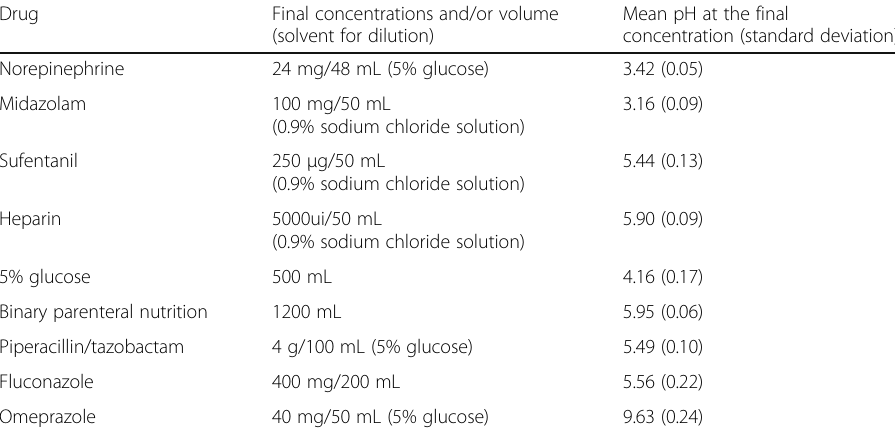
Table 2 Mean pH of the drug solutions at their final concentration Drug Final concentrations and/or volume (solvent for dilution)